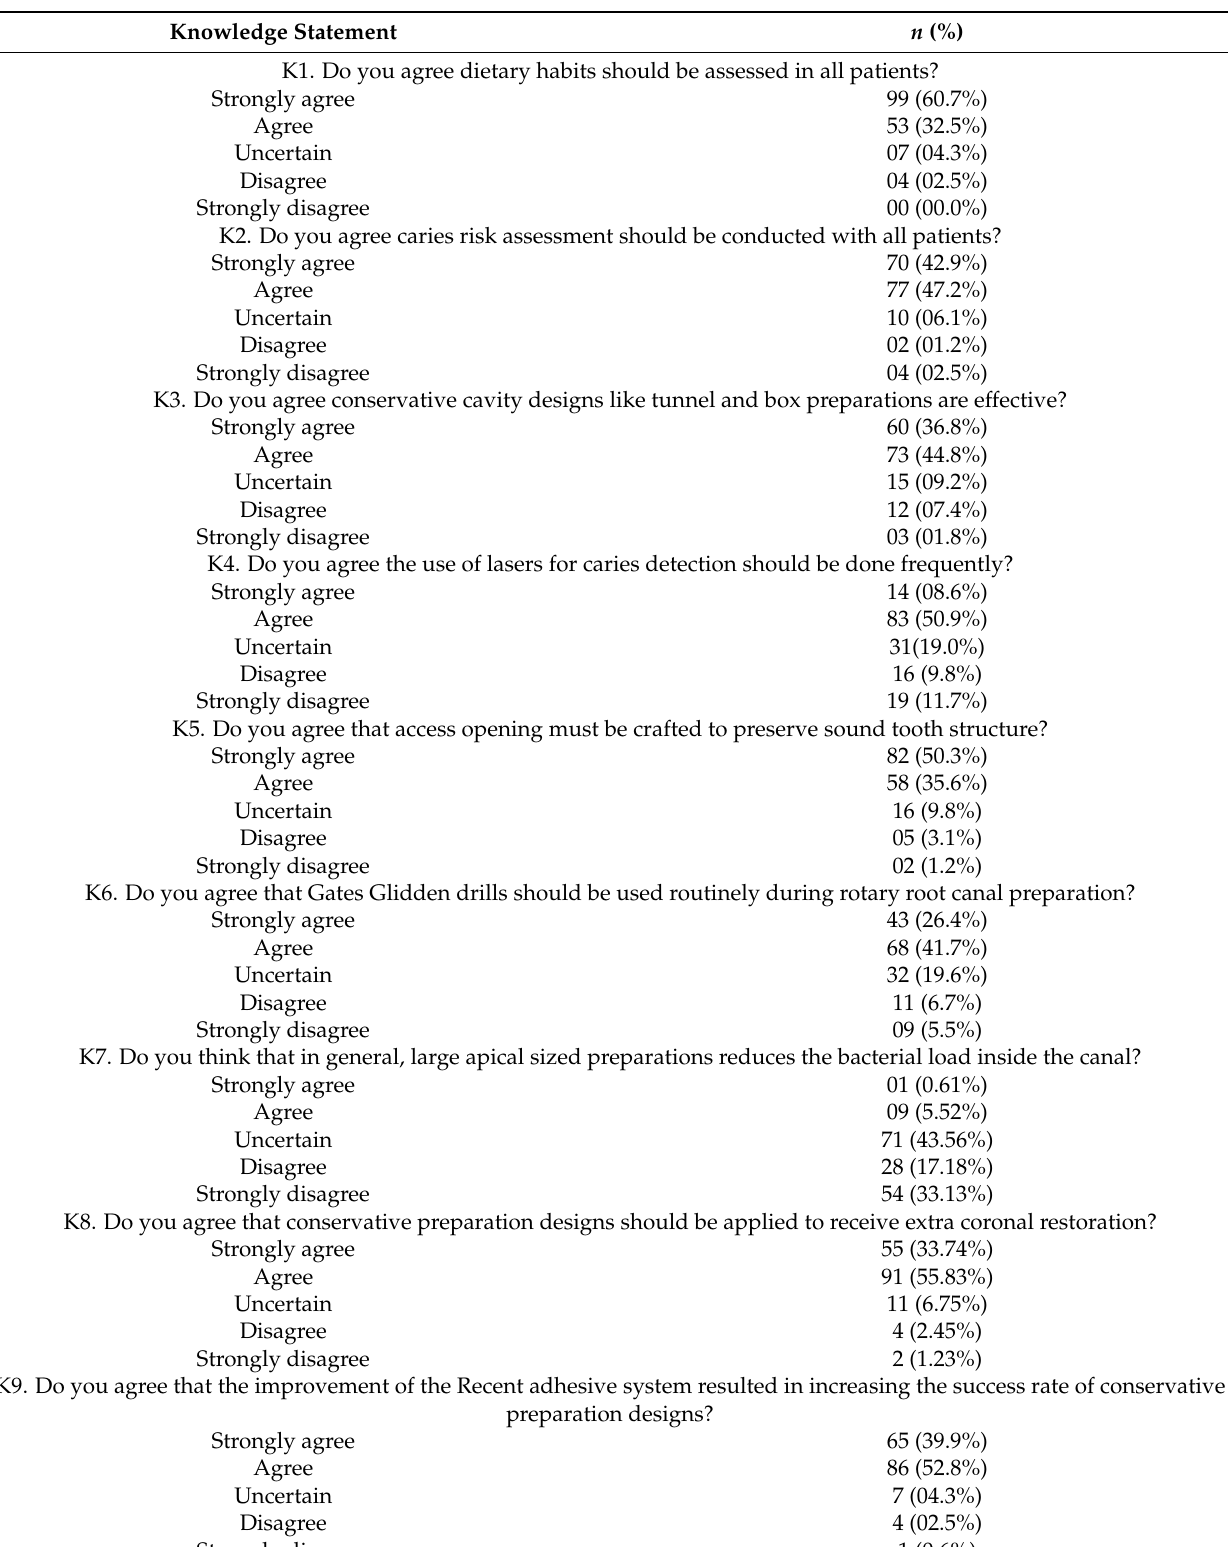
Table 2. Respondents’ responses to questions related to assessment of knowledge (K) of